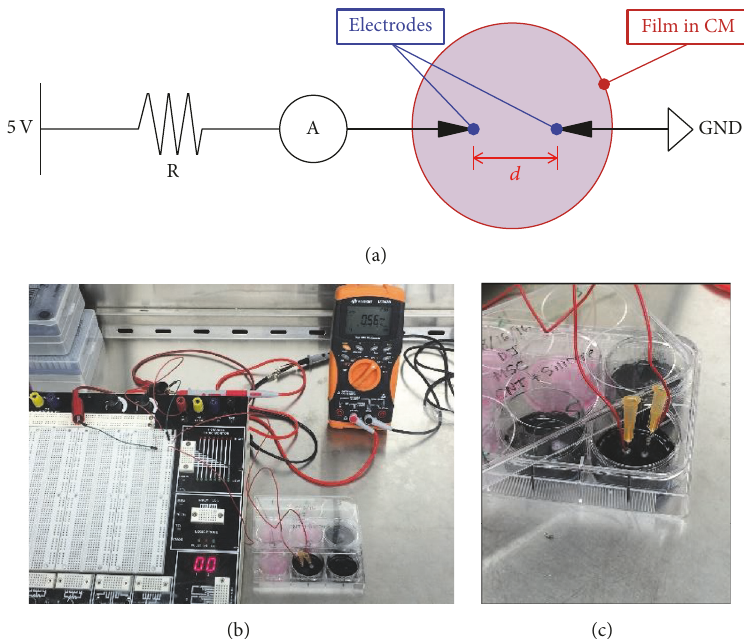
Figure 3: (a) Circuit diagram and (b) actual experimental setup for application of electric current to the composite films soaked in culture medium. (c) Close-up image of the electrodes penetrating the silicone substrate with collagen and carbon nanotube fibers. 𝑅 = resistor, 𝐴 = ammeter, GND = ground, and 𝑑 = distance separating the two